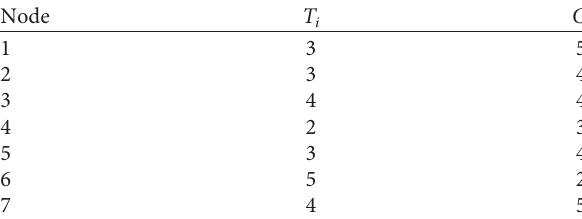
Table 3: Basic data of nodes for example I.